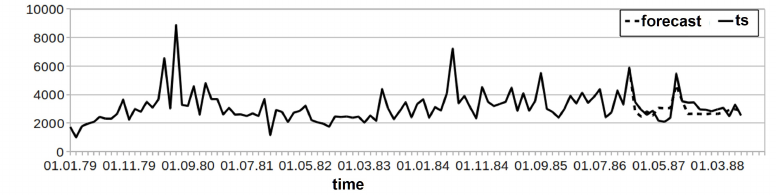
Figure 9. Time series forecast in the test part.